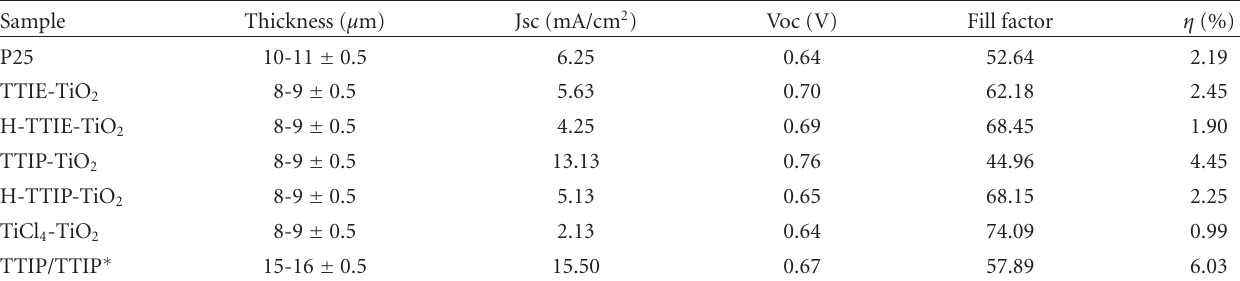
Table 2: Performances of various TiO 2 thin film electrodes for DSSC.